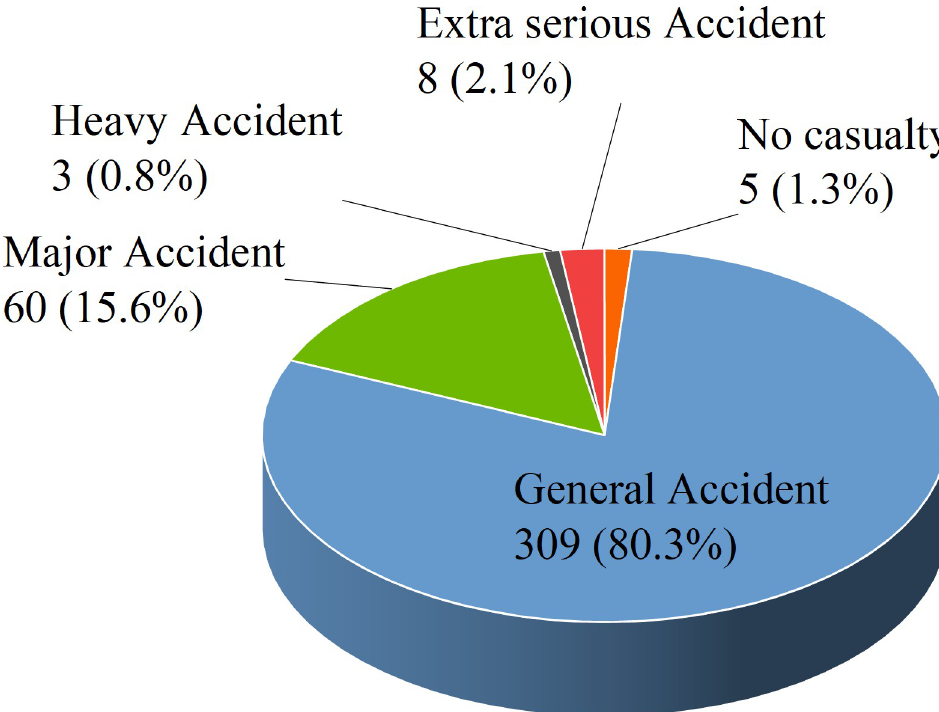
Fig 2. Lifting injury accident grade